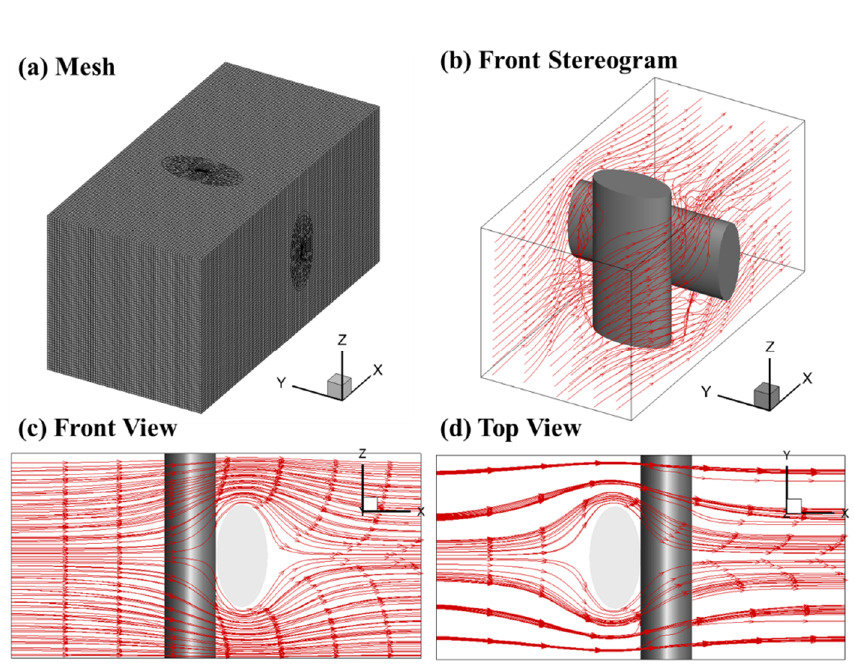
Figure 3. ( a ) Mesh and ( b – d ) fluid field together with streamlines around the clean woven fibers of Case 2.